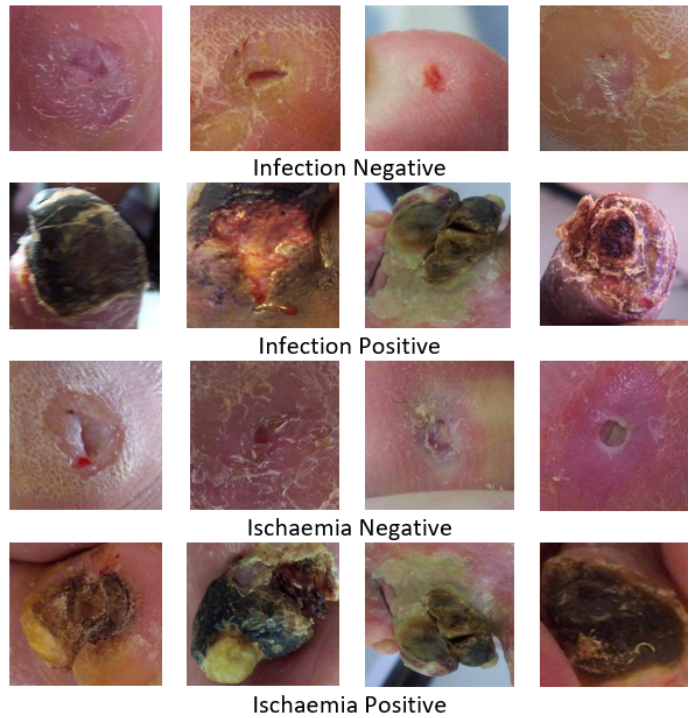
Figure 2. DFU2020 dataset: Sample images of infection (negative and positive) and ischaemia (negative and